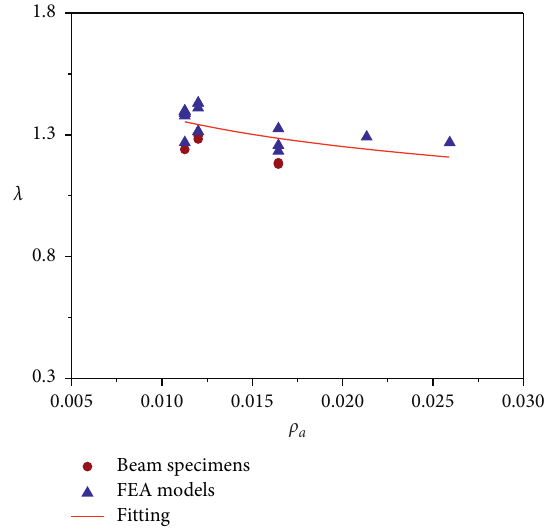
Figure 10: Relation of amplifying factor λ and steel ratio ρ